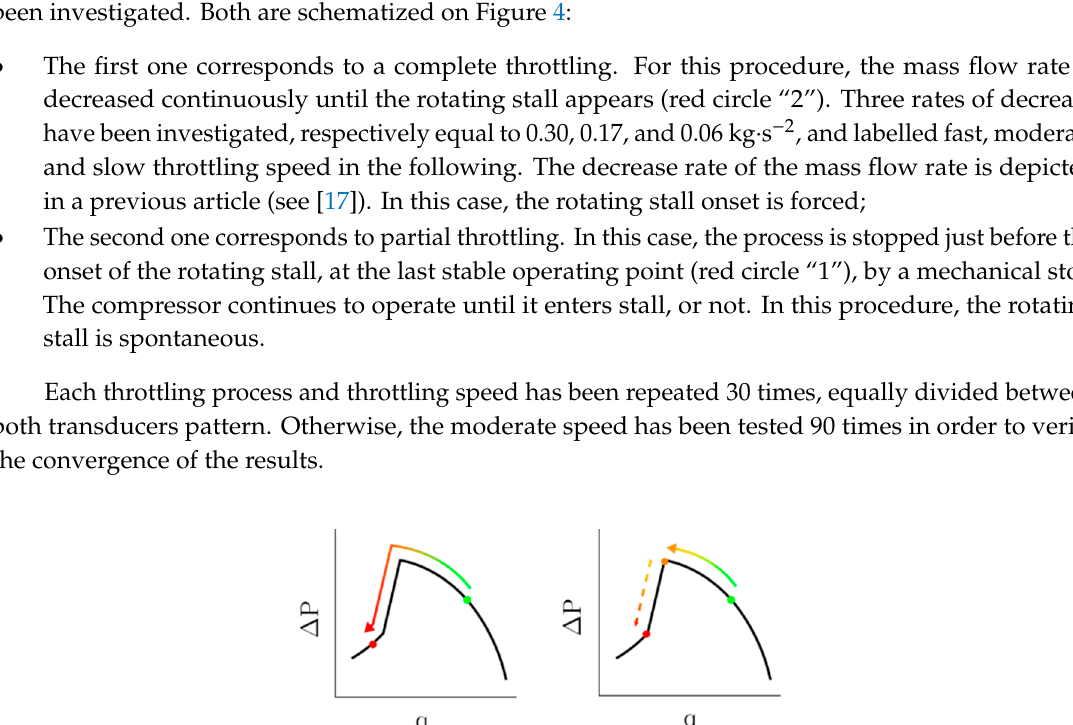
Figure 4. Schematic representation of the throttling process. ( a ) Complete throttling; ( b ) partial throttling.